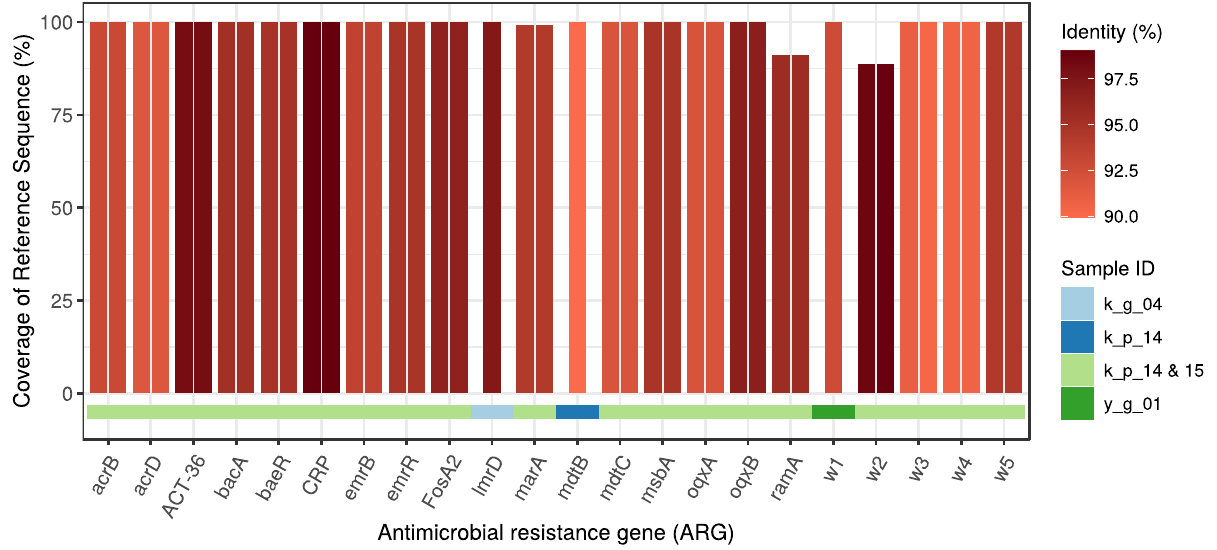
Figure 6. Identified ARGs excluding nudged findings. The coverage and identity of detected open reading frames (ORFs) by antimicrobial resistance genes (ARGs). The ORF covered proportion of the reference ARG sequence and the identity % of predicted protein (colour). The gene names which are too long have been abbreviated (w1: Bifidobacterium adolescentis rpoB mutants conferring resistance to rifampicin; w2: Escherichia coli EF-Tu mutants conferring resistance to Pulvomycin; w3: E. coli marR mutant conferring antibiotic resistance; w4: E. coli soxS with mutation conferring antibiotic resistance; w5: E. coli UhpT with mutation conferring resistance to